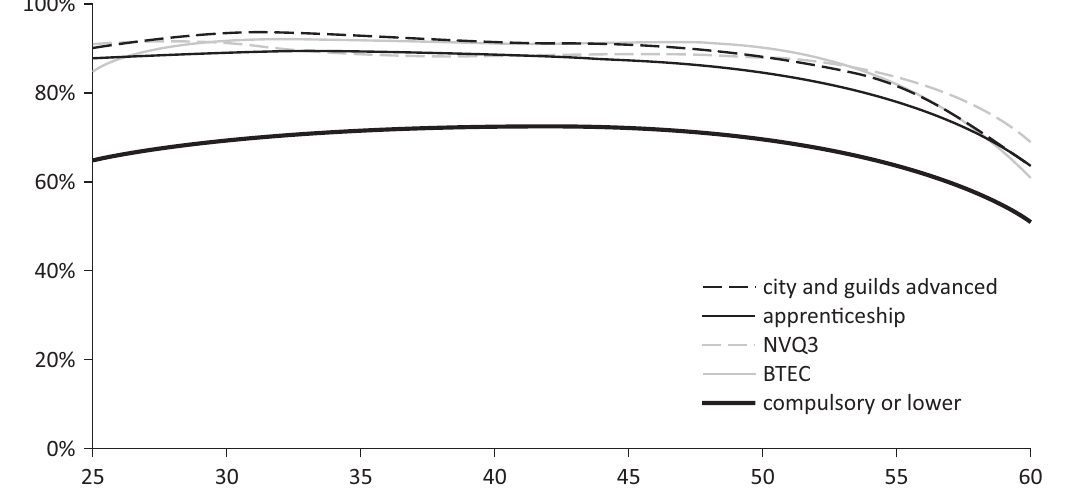
Figure A2. Employment rate (minimun 8 hours per week) by type of upper-secondary vocational education. Men—United Kingdom. Source: UK Labour Force Survey 1993–2014.